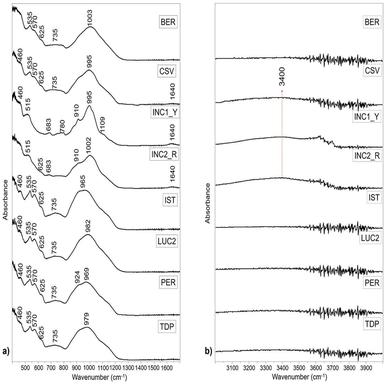
FTIR-ATR absorbance spectra of the sample set: a) 400–1700 cm− 1 region; b) 3000–4000 cm− 1 region.